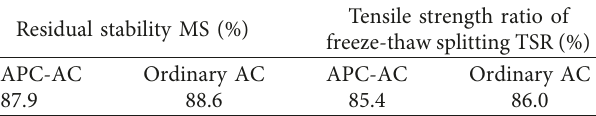
Table 10: Results of the Marshall stability tests and freeze-thaw splitting tests for different asphalt mixtures.